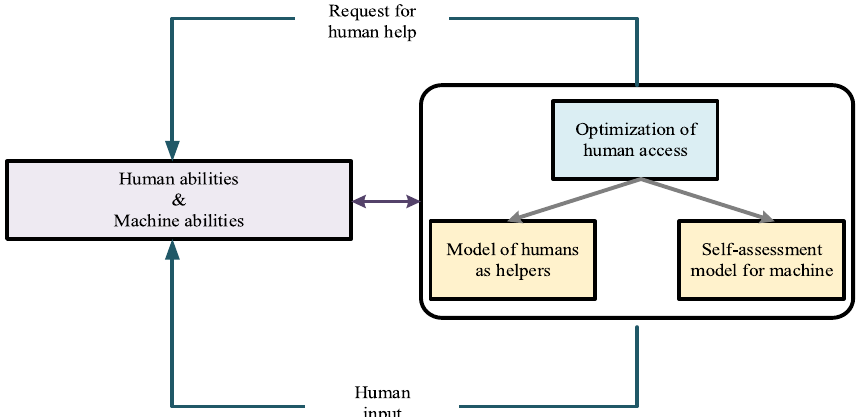
Fig. 4 Reasoning capabilities of hybrid intelligence